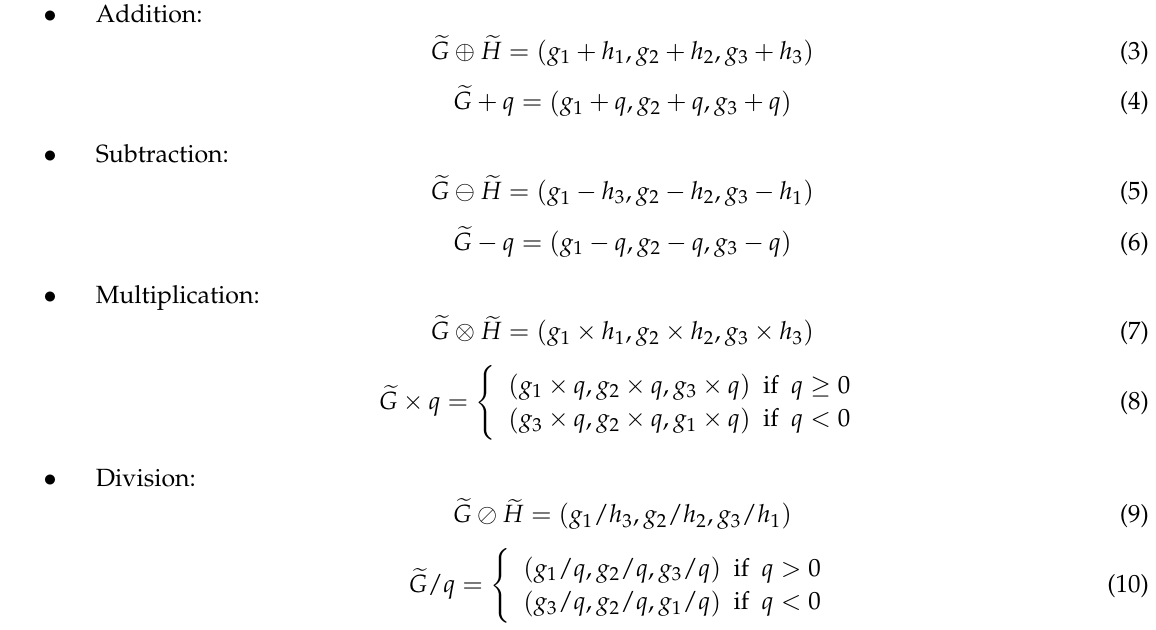
Figure 1. A triangular fuzzy number.